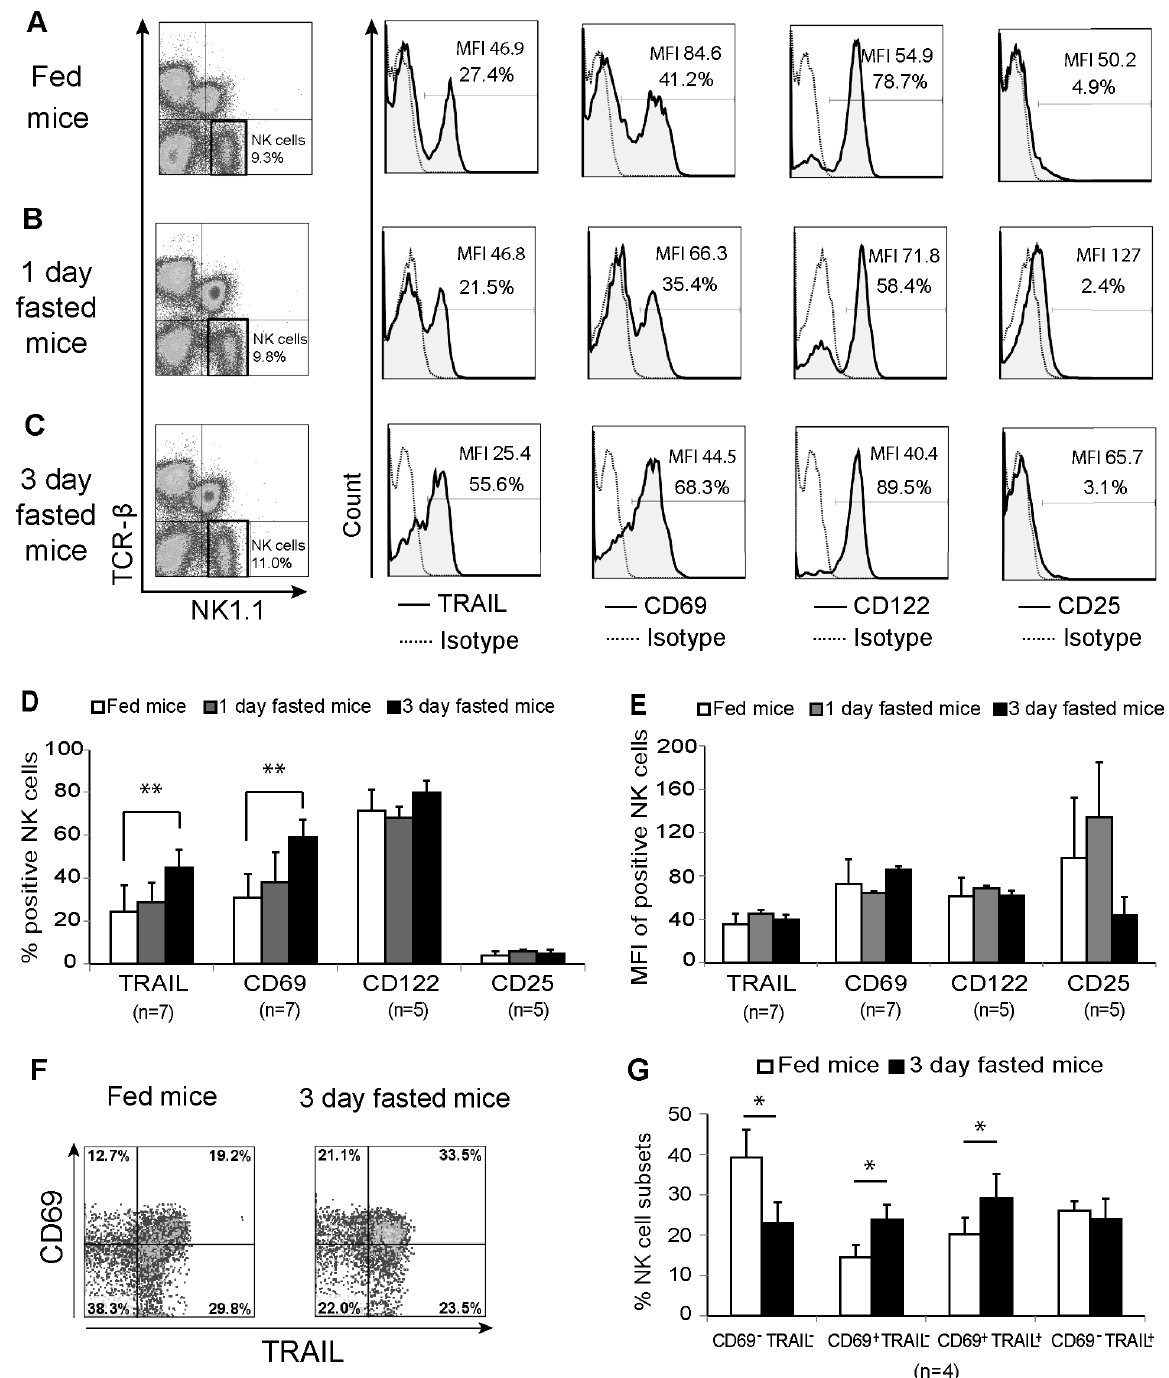
Figure 1. Phenotype of liver natural killer cells under starvation. Isolated liver lymphocytes from 3 mouse groups were stained with monoclonal antibodies against the cell surface markers TRAIL, CD69, CD122, and CD25 prior to analysis by flow cytometry. Representative natural killer (NK) cell phenotype analyses from (A) fed, (B) 1-day-fasted and (C) 3-day-fasted mice are presented in dot plots and histograms. TCR b 2 NK1.1 + cells were gated as NK cells. The dotted lines represent the negative control. The distribution of TRAIL, CD69, CD122, and CD25 expression in NK cells is indicated by the solid lines (shaded areas) and the percentage and mean fluorescence intensity (MFI) of positive cells are provided. (D) The percentages or (E) MFI of liver NK cells that are positive for TRAIL, CD69, CD122, and CD25 are shown in bar graphs as mean plus standard deviation. (F) Dot plots of representative data and (G) bar graph present the mean plus standard deviation of proportion of NK cell subsets regarding to TRAIL and CD69 expression in fed and fasted mice; * p , 0.05, ** p , 0.01 as analyzed by the independent samples T test.